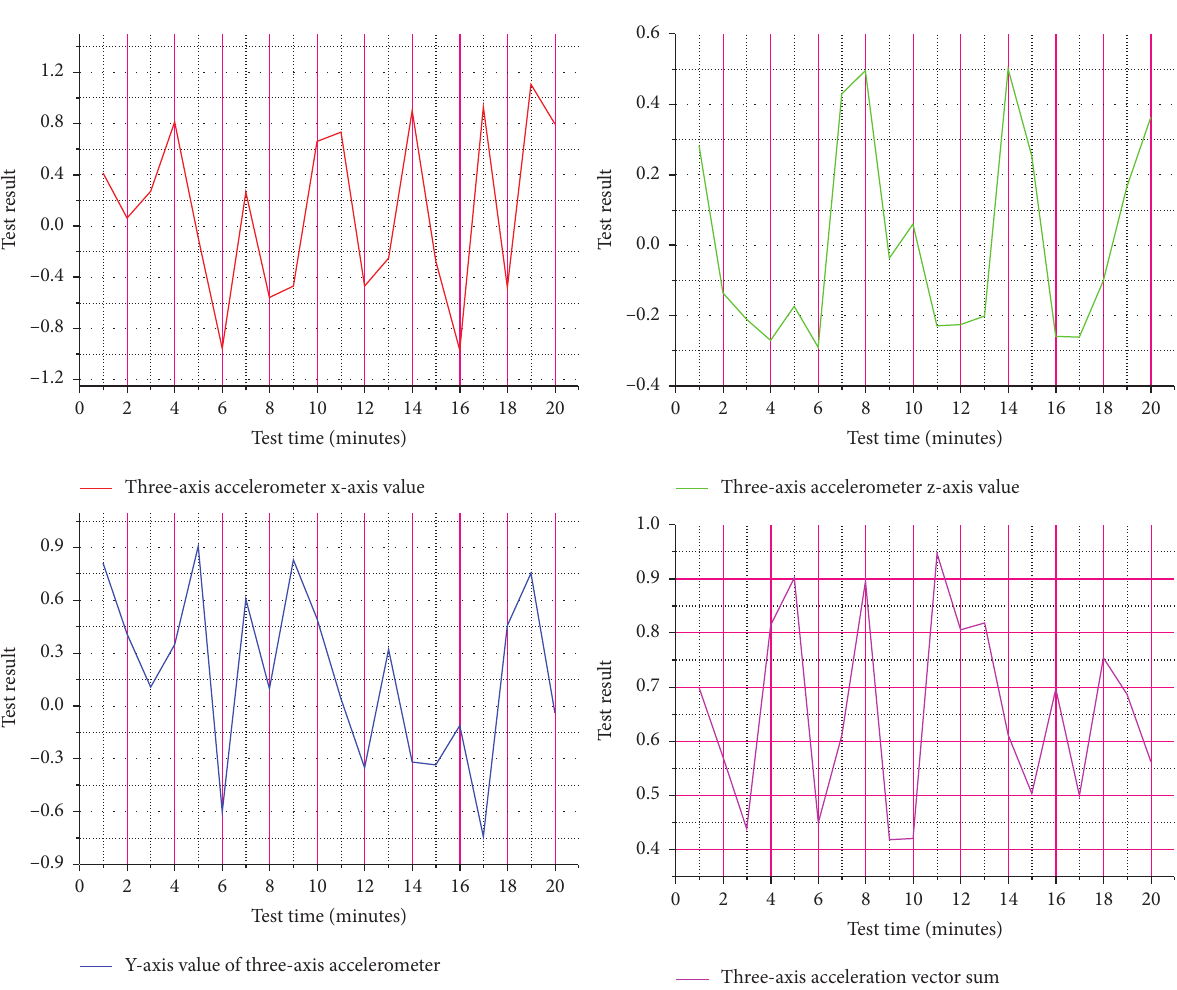
Figure 5: Curves of the triangle accelerometer measurements received at the platform side.